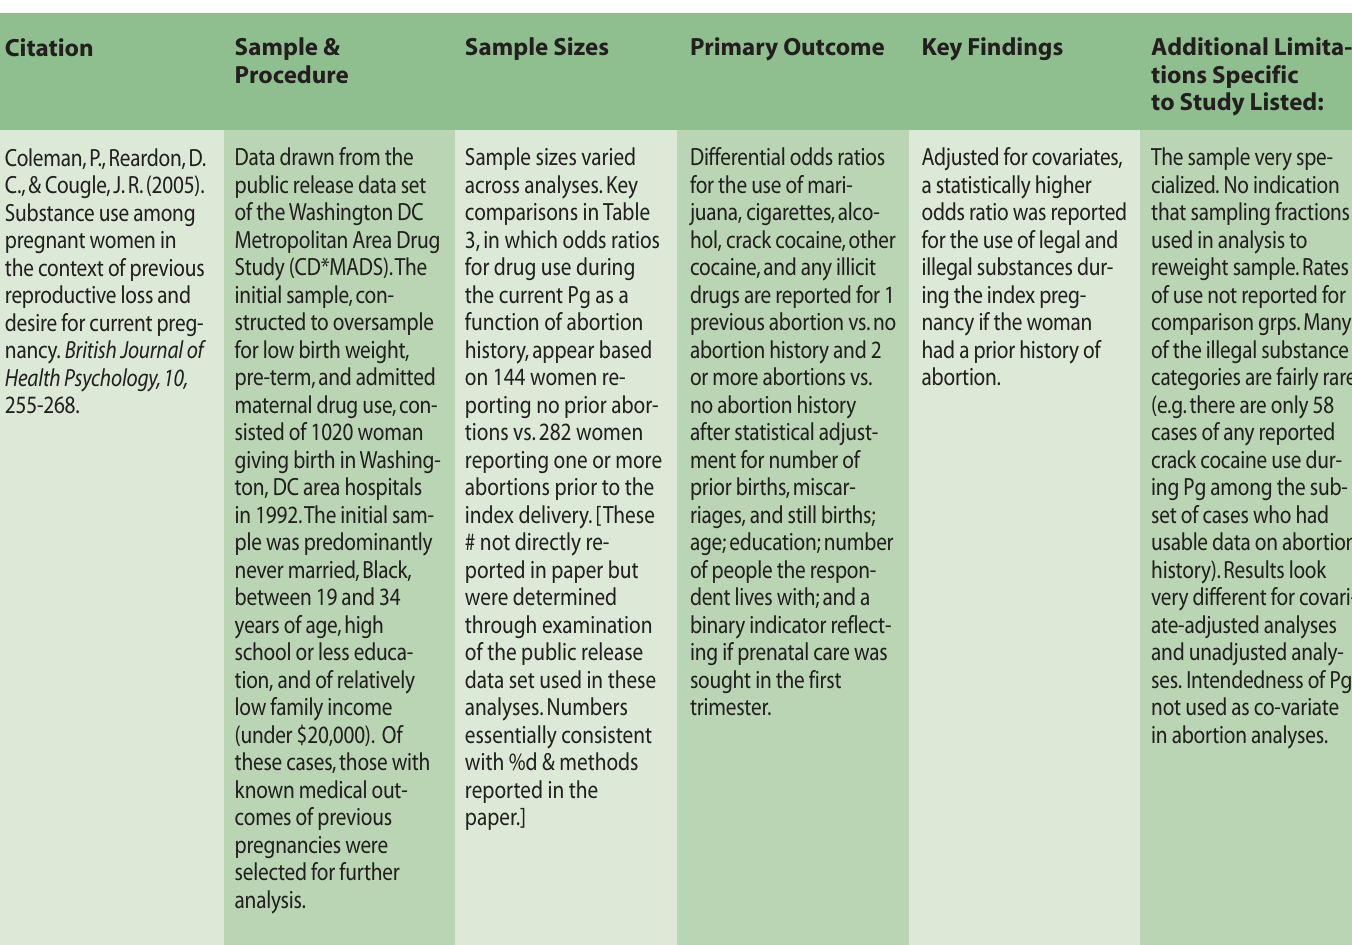
Table 2: Secondary Analyses of Survey Data–Abortion vs.Comparison